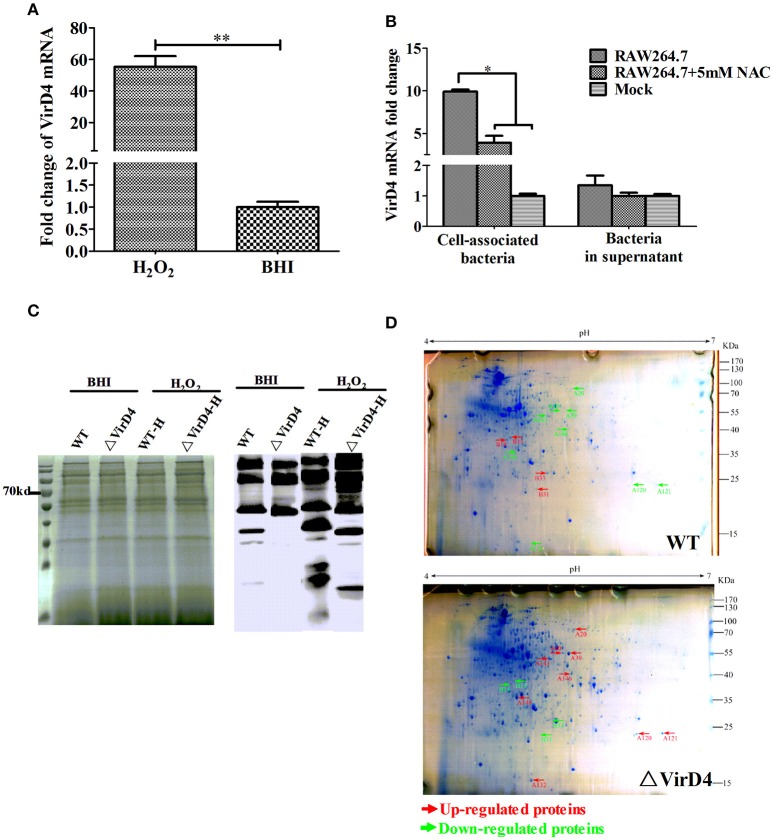
The virD4 gene was induced by hydrogen peroxide treatment and its deletion could induce differentially secreted protein profiles between wild-type (WT) S. suis type 2 and ΔVirD4 strains subjected to oxidative stress. (A) The virD4 mRNA level from the wild-type S. suis type 2 strain subjected to hydrogen peroxide treatment. **Indicated significant at P < 0.01. (B) The virD4 mRNA transcripts of the cell-associated bacteria and unassociated supernatant bacteria (bacteria in supernatant) after 2 hs infection in RAW264.7 cells in the presence or absence of N-acetyl-l-cystein (NAC), a reactive oxygen species inhibitor. *Indicated significant at P < 0.05. (C) Differentially secreted proteins were found in regular SDS-PAGE gels and confirmed by Western blotting. (D) Differentially secreted supernatant protein profiles detected by 2DE. Red and Green arrows indicate some upregulated or down-regulated proteins in the wide-type or ΔVirD4 strains compared between the two gels that were used for LC/MS.